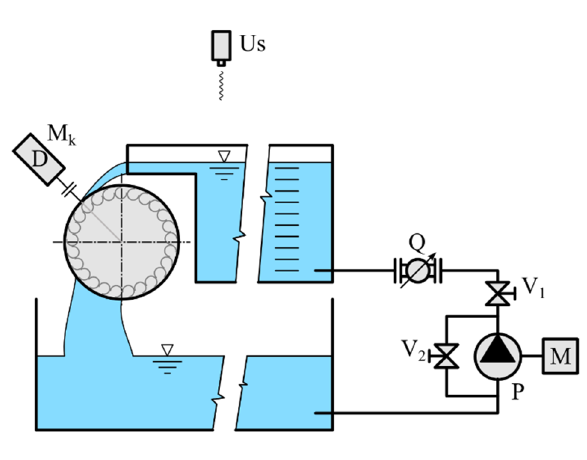
Fig. 3. Testing circle schema